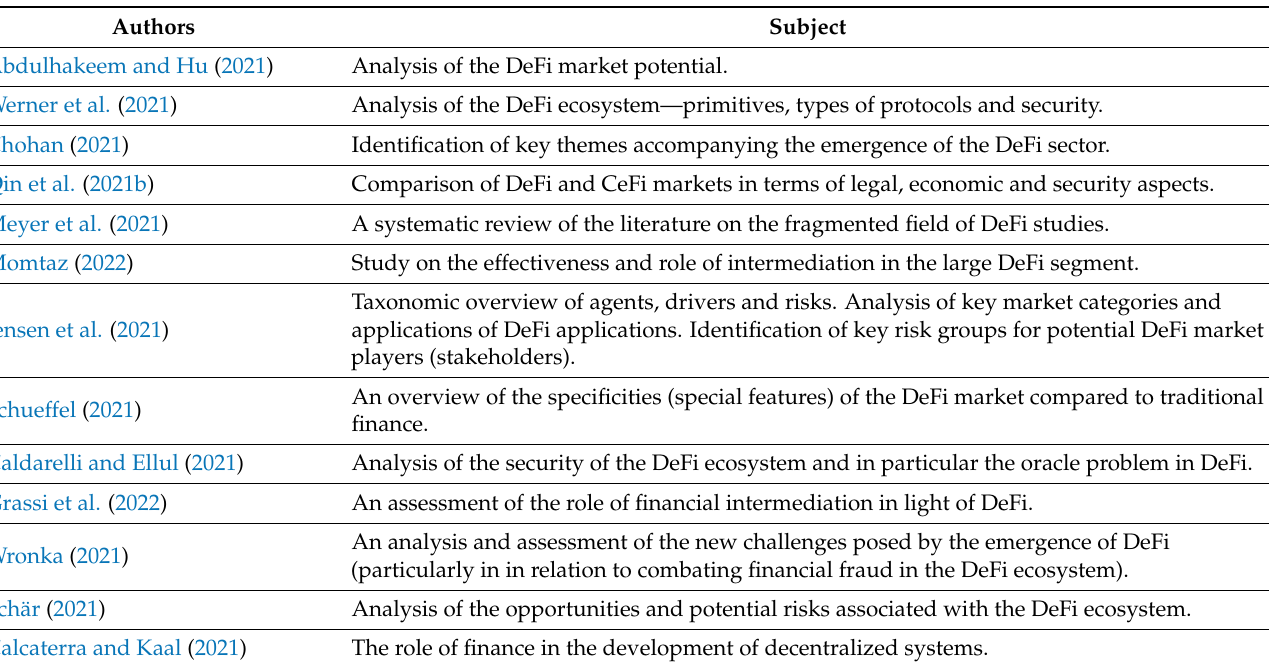
Table A1. Important works/studies dealing with DeFi protocols/project